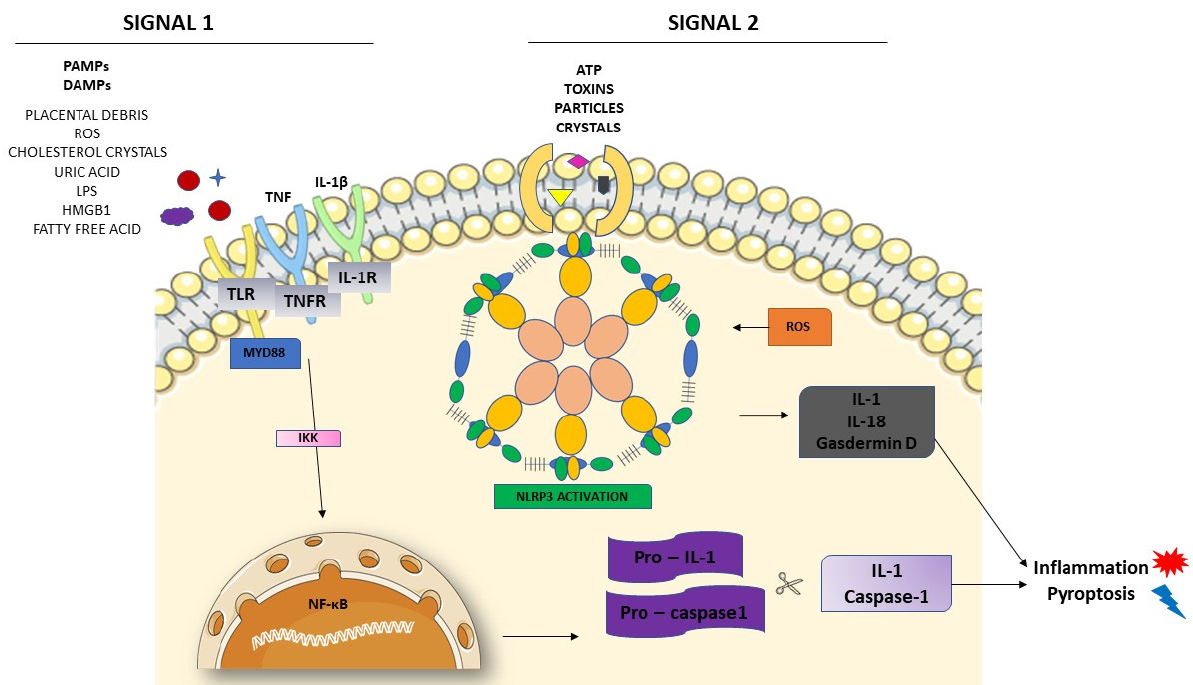
Figure 2. NLRP3 inflammasome activation. The priming signal (signal 1) occurs in the presence of danger signals (PAMPs and DAMPs), leading to the activation of the NF- κ B and subsequent upregulation of NLRP3 and pro-IL-1 and pro-caspase1. The activation signal (signal 2) starts with the direct activation of the NLRP3 inflammasome with ROS recruitment. The process leads to inflammation and pyroptosis.